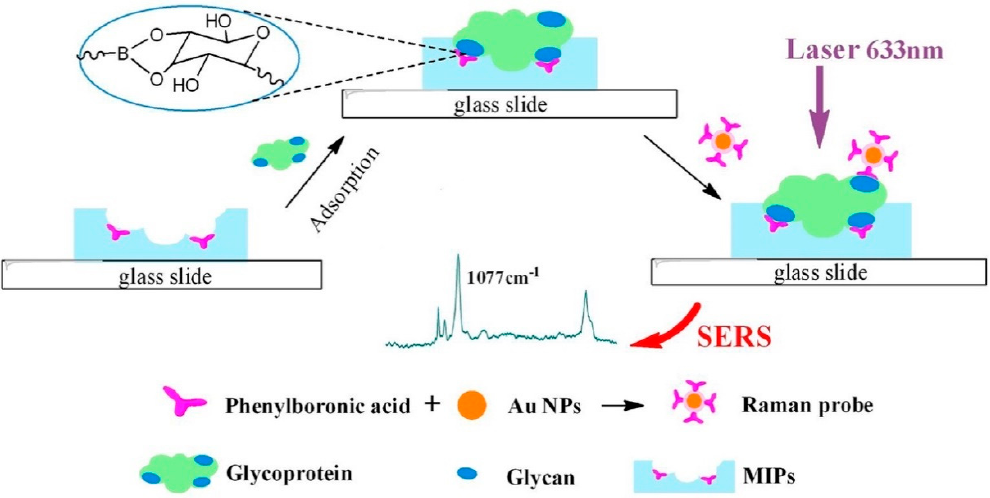
Figure 4. Schematic representation of the biomimetic recognition-based SERS sensor through self-polymerization of dopamine on the surface of glycoprotein-immobilized polymeric skeletons for the detection of target glycoprotein. Reproduced from Reference [82] with permission of Elsevier.